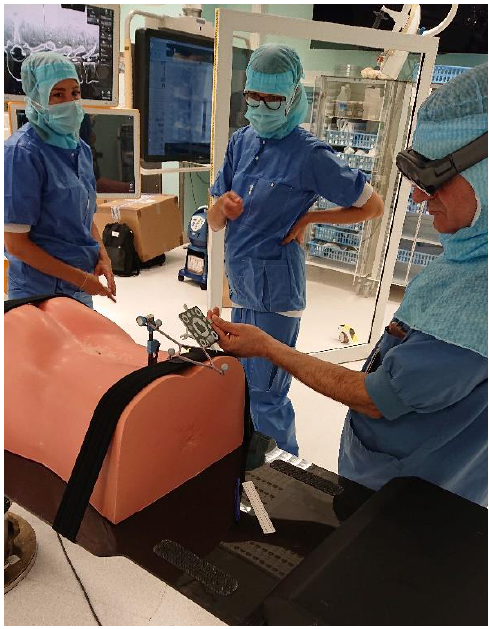
Figure 9. The surgeon calibrating the HMD to the navigation system using a hybrid marker. Liebmann et al. performed a study where they used the HoloLens to place pedicle screws in an open lumbar spine model and reported 2.77 ± 1.46 mm mean deviation from the planned path at the entry point and an angular deviation of 3.38°± 1.73° [25]. When